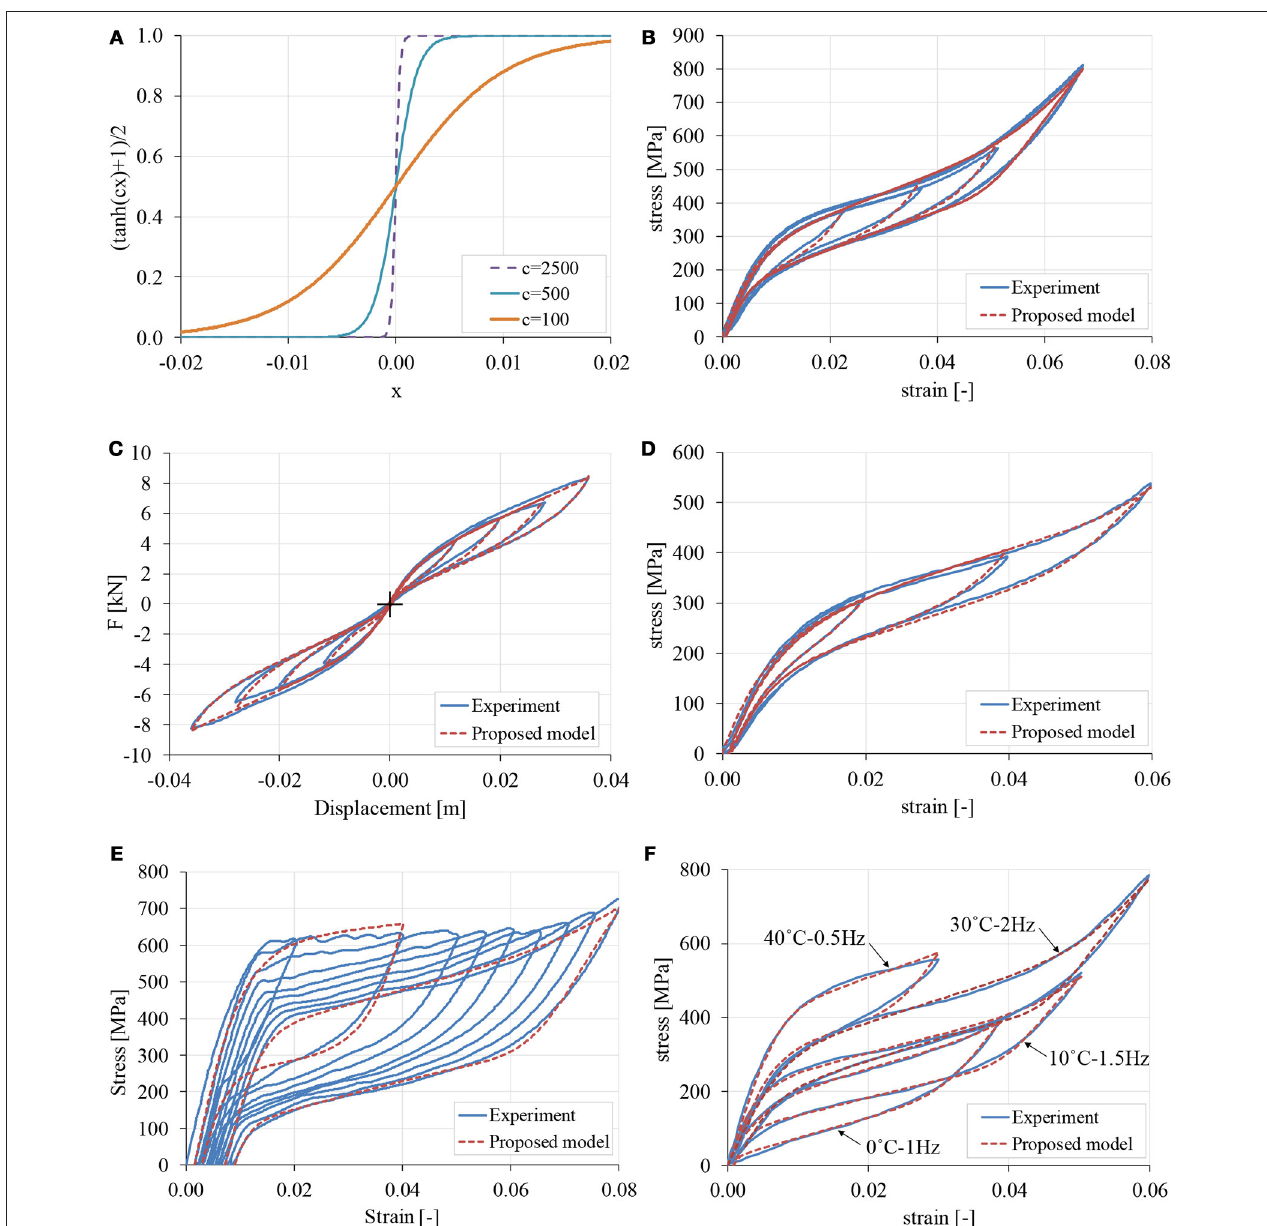
FIGURE 5 | (A) Logistic function f ( x ) (tanh ( cx ) 1) / 2 for various values of coefficient c , and curve fit of the proposed model with experimental data obtained from = + (B) Zhang and Zhu (2007), (C) Zhuang et al. (2016), (D) Ozbulut et al. (2010), (E) Auricchio et al. (2003), (F) Ozbulut and Hurlebaus